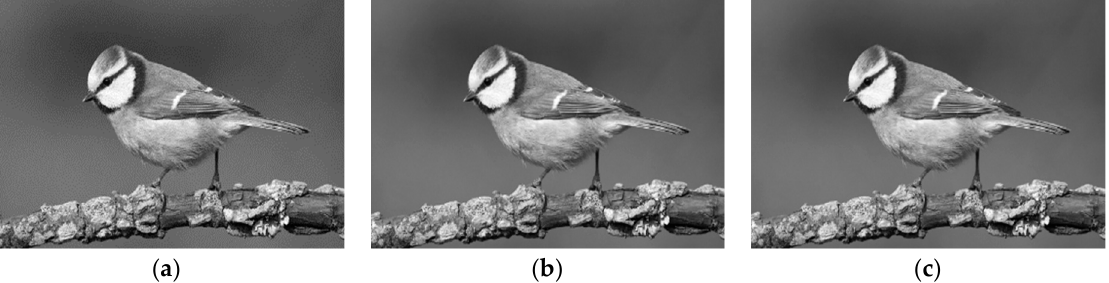
Figure 9. Original, Encoded, and Polyglot images in our experiments. ( a ) Original image; ( b ) Encoded image; ( c ) Polyglot image.